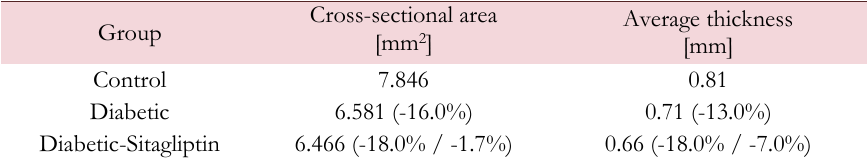
Table 2: The geometrical characteristics of the groups tested.